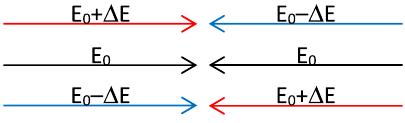
FIG. 1. Monochromatization scheme for head-on collisions.